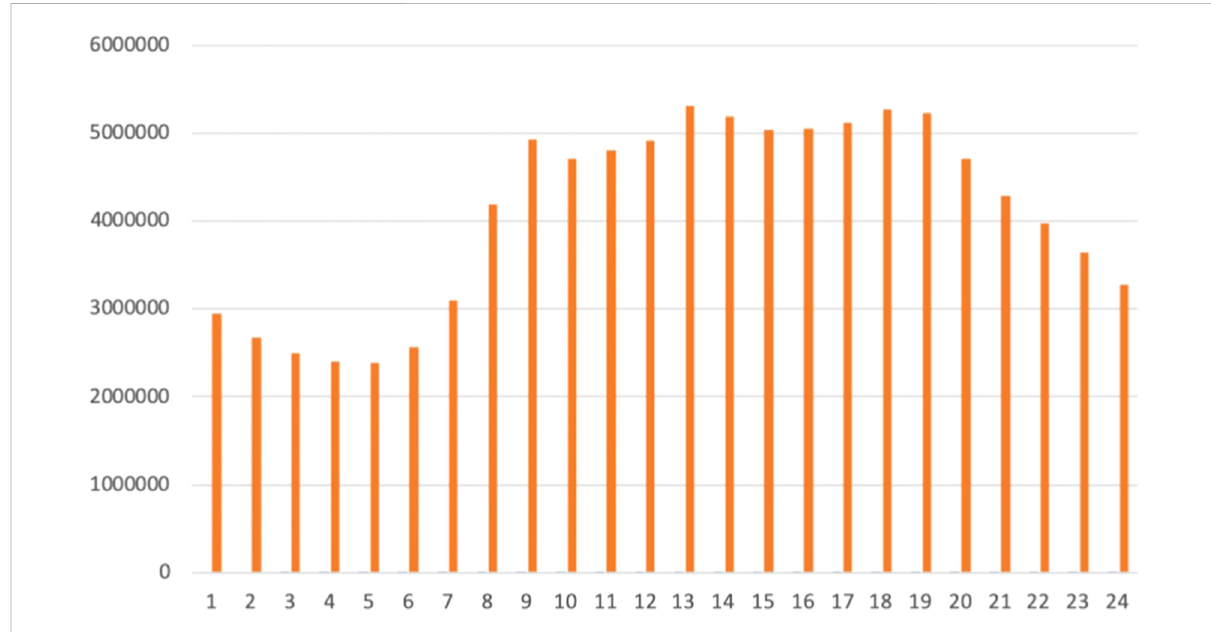
FIGURE 1 Totalnumberofdatalogsbytimeslot.Notably,thenumberofmeasurementsishighduringthedaytimewhenpeopleareactivelymovingandis low at